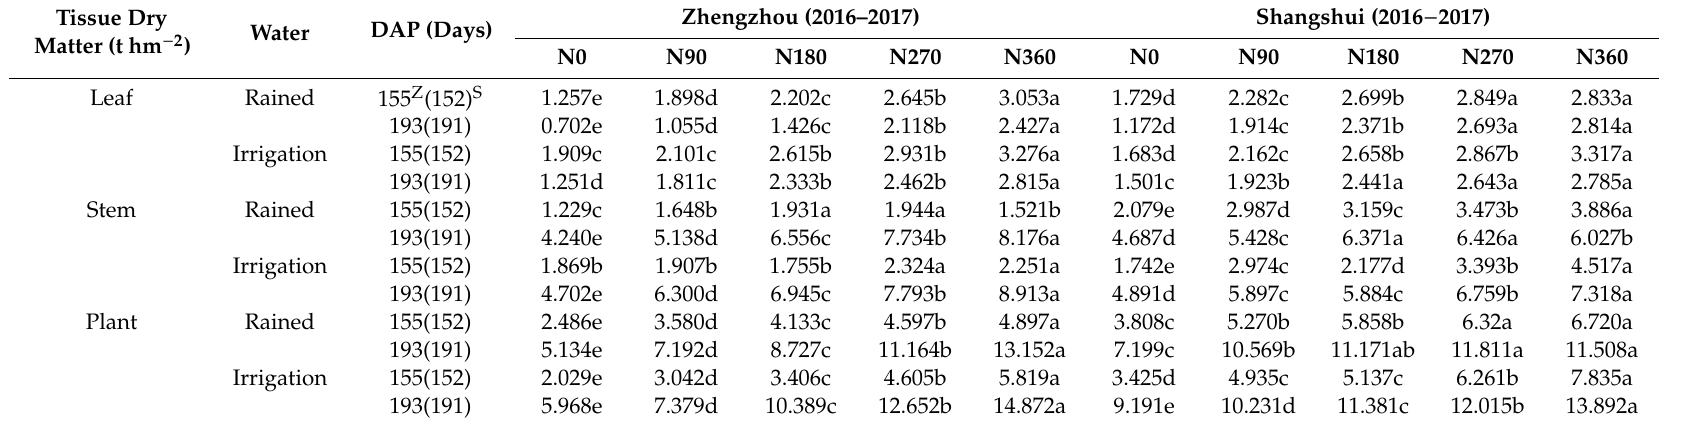
Table 3. E ff ects of N rate and water on tissue dry matter under di ff erent years and sites in Exp. 2 and